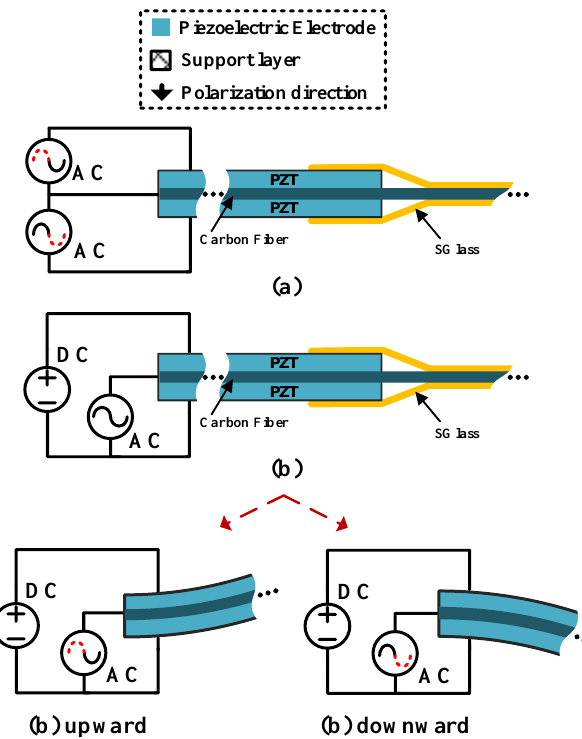
Figure 3. Driving methods for piezoelectric actuators: ( a ) Bimorph with alternating driving; ( b ) bimorph with simultaneous driving.